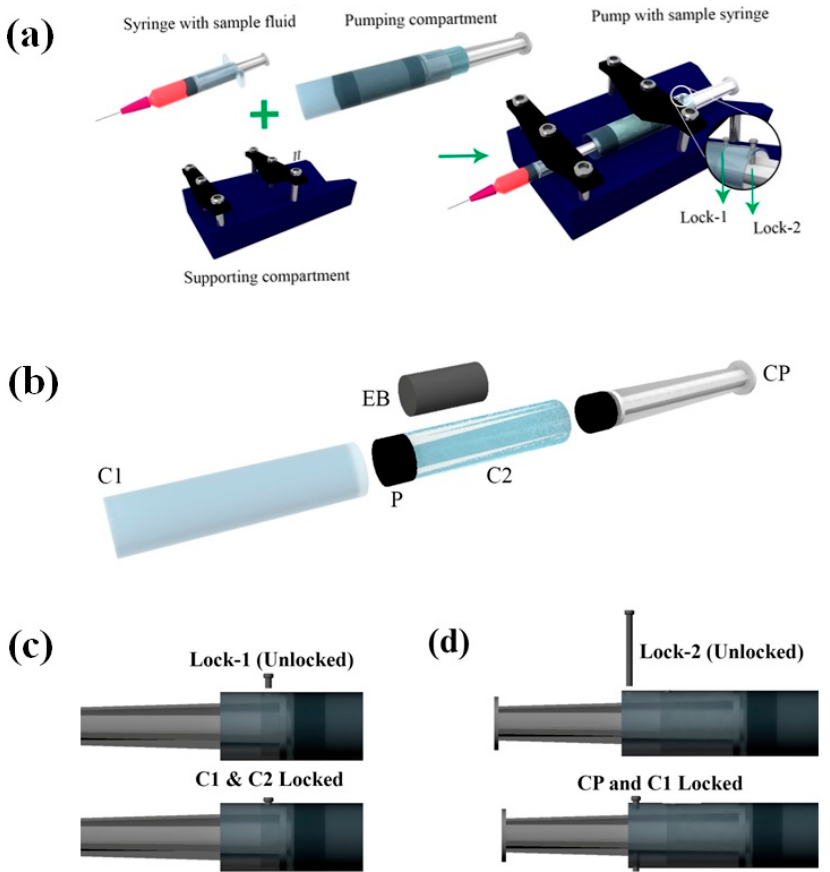
Figure 1. Schematics illustrating the various components of the pump. ( a ) Schematic of the pump and its various sub-compartments. Inset shows the locks used for locking and unlocking C1, C2, and CP. ( b ) Exploded view of the pumping compartment. ( c , d ) Schematics illustrating the locking and unlocking mechanism for locks 1 and 2, respectively. C1—large cylindrical tube, C2—small cylindrical tube, P—piston rubber, EB—elastic block, CP—compressor. Note: The direction of viewing for the figures (a,b) is in the opposite direction to that of (c,d).